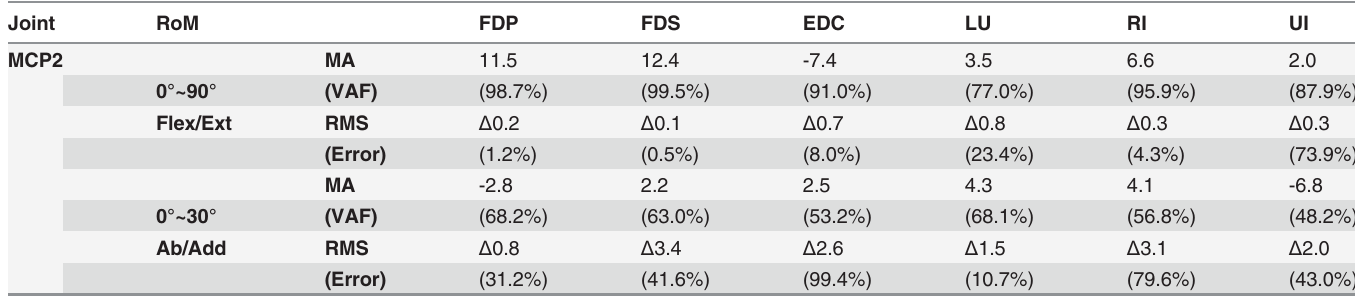
All are expressed in millimeters (mm) with fl exion (+)/ extension (-) and abduction (+)/ adduction (-) at the MCP joint (degree) of the index fi nger. (VAF) represents Variance Accounted For, RMS represents root mean square error ( Δ ) between derived moment arms [5] and experimentally measured values [20], and (Error) represents percentage error,